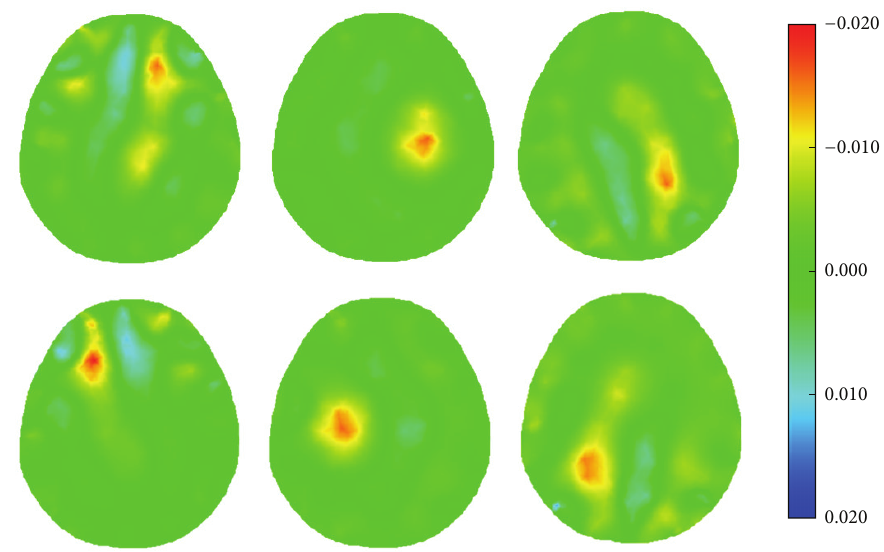
Figure 19: SEIT reconstructions of the simulated hemorrhagic stroke lesion at different locations of the 2D head model.